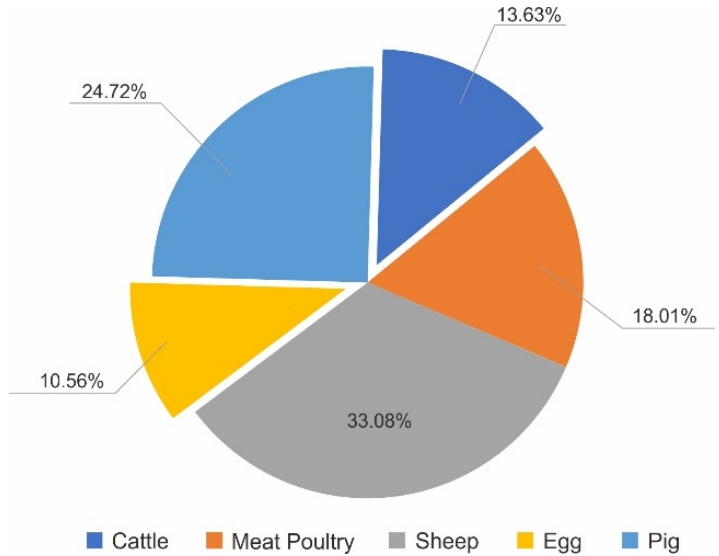
Figure 9. Proportions of product contributing to animal husbandry.